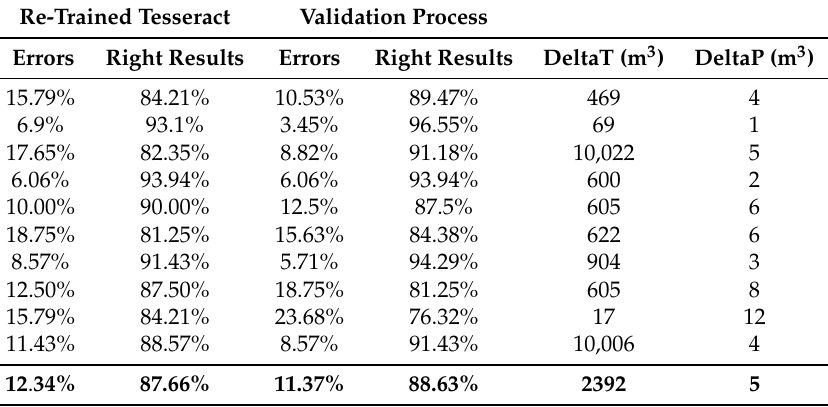
Table 4. Comparision between re-trained Tesseract network and validation process for dumb meter of type